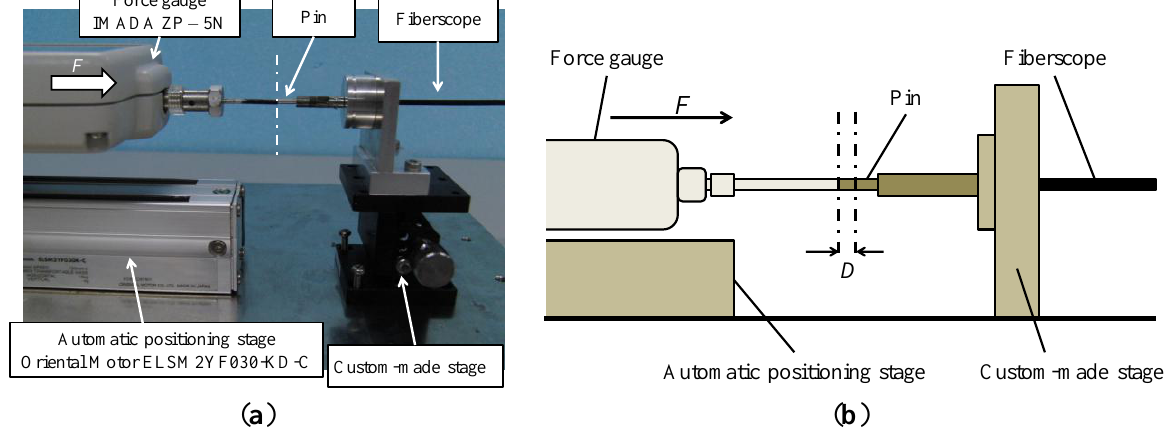
Figure 5. ( a ) Picture of experimental setup ( b ) Image of experimental